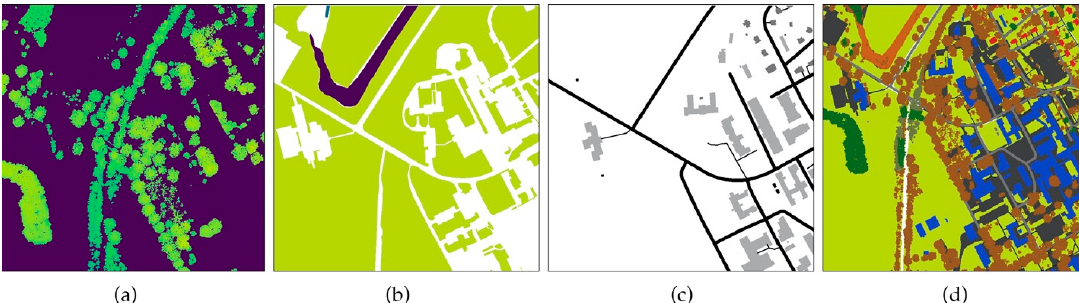
Figure 3. Landcover fusion layers include ( a ) tree canopies derived from lidar points, ( b ) ground cover digitized over high-resolution imagery and ( c ) roads and buildings rasterized from official vector data which are combined to generate the ( d ) half meter resolution landcover. Data sources: (a) Phase 3 NC QL2 lidar (2015); (b) NAIP, USDA Farm Services Agency, 2014; (c) City of Raleigh GIS datasets; Raleigh Open Data server.